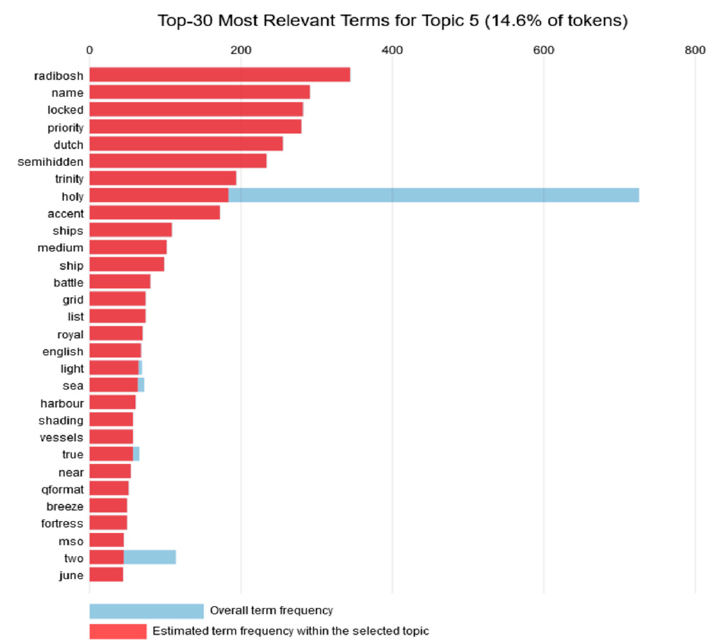
Figure 6. Top-30 most relevant terms for Topic 5.